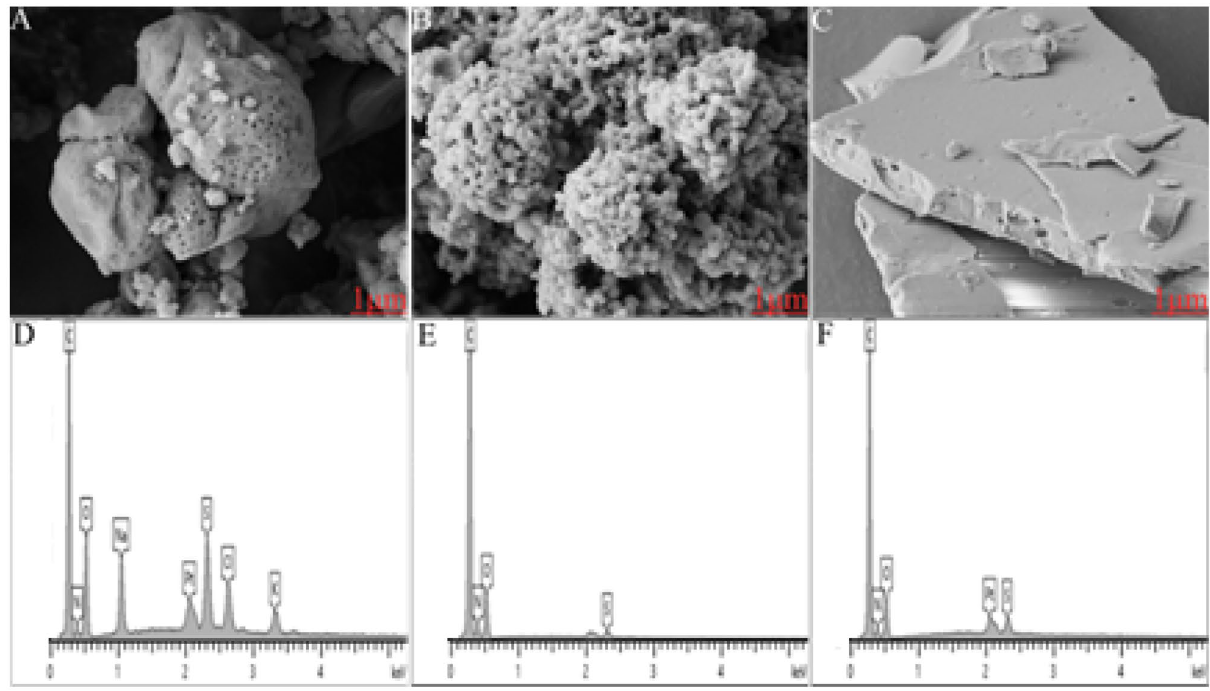
Figure 5. Field emission-scanning electron micrograms (FE-SEM) of proteins at magnification of 1 μm, voltage of 5.00 V, aperture size of 20.00 μm using secondary electron beam signal. ( A ) Kafirin from dried distillers sorghum grain with solubles, DDGS; ( B ) grain kafirin; ( C ) zein. Energy dispersive X-ray spectroscopy of proteins. ( D ) DDGS kafirin; ( E ) grain kafirin ( F )